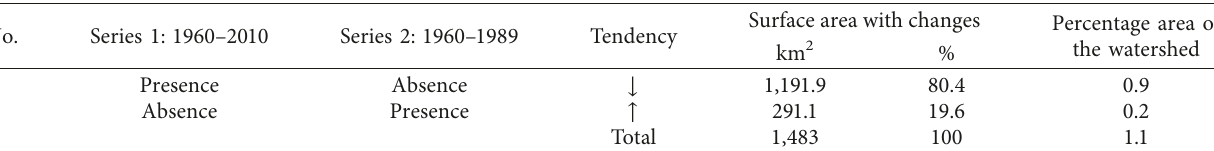
Table 5: Absolute, relative, and proportional areas of the Lerma-Chapala-Santiago watershed with changes in the presence or absence of mid-summer drought between time series one (1960–2010) and time series two (1960–1989). No.